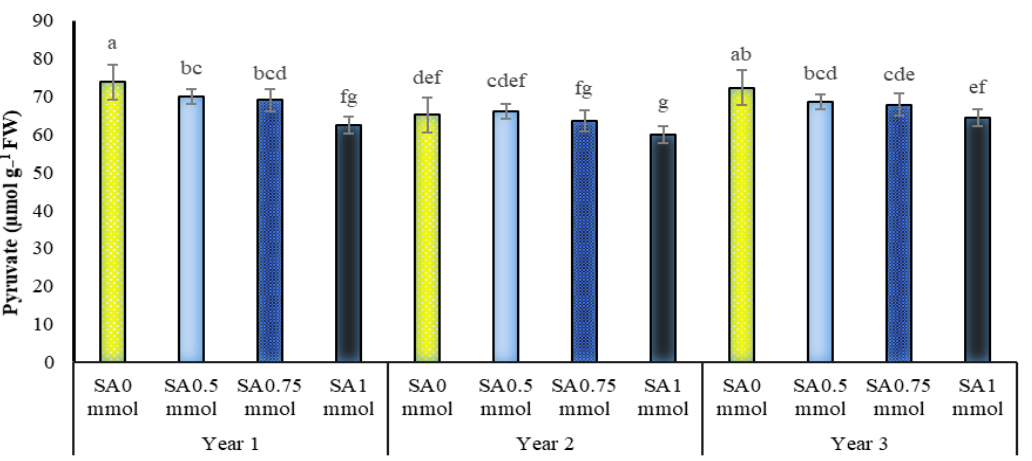
Figure 10. Dual interaction of experimental years (2016 – 2017, 2017 – 2018, and 2018 – 2019) and sali- cylic acid application concentrations (SA0 = non-application, SA0.5 = 0.5 mmol, SA0.75 = 0.75 mmol and SA1 = 1 mmol) on the pyruvate (sharpness) of A. hirtifolium . Columns designated by the